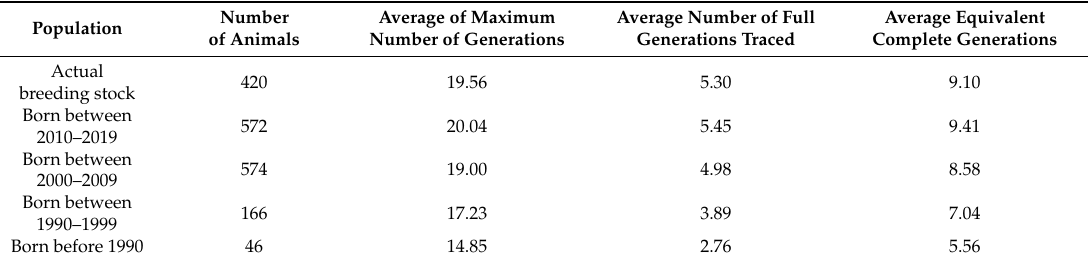
Figure 1. Pedigree completeness of the di ff erent reference groups. Table 1. Description of the quality of the